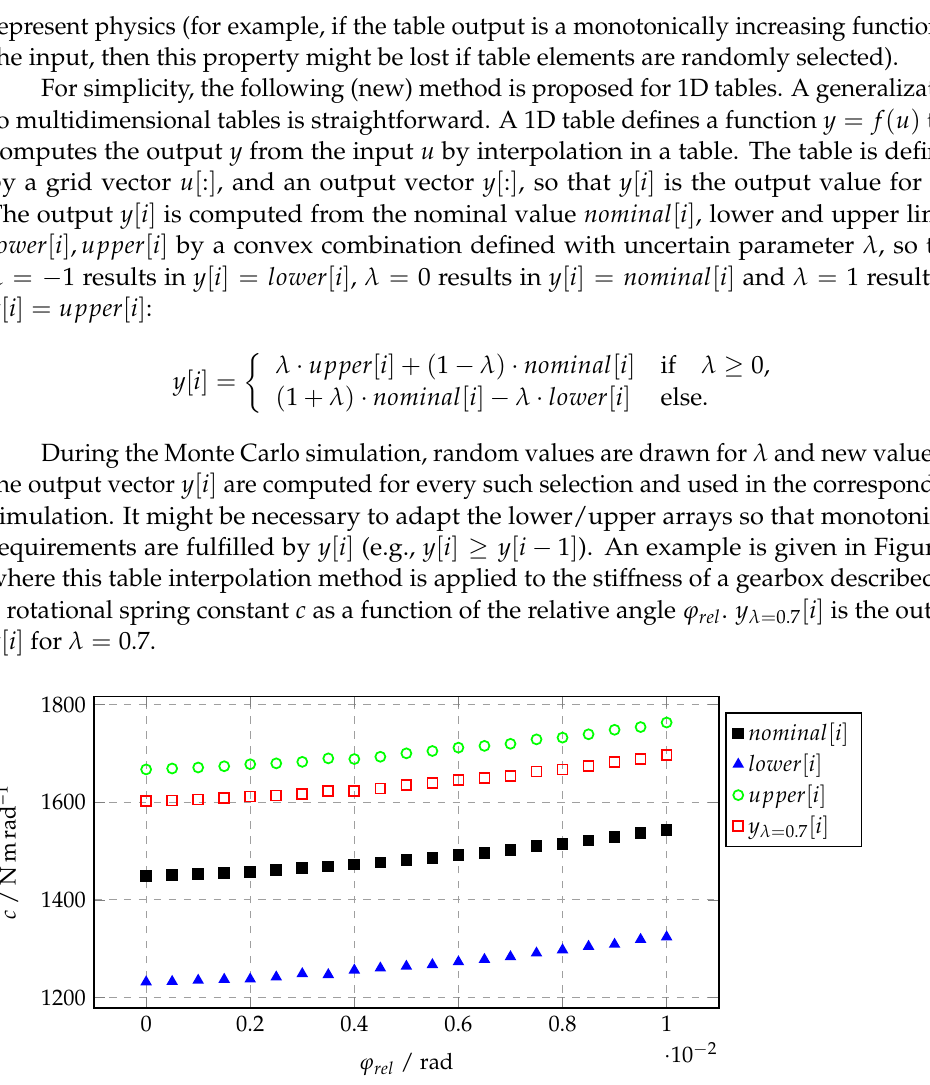
Figure 4. Exemplary data of an uncertainty table. Values of y λ = 0.7 [ i ] are calculated by Equation (8) for λ =